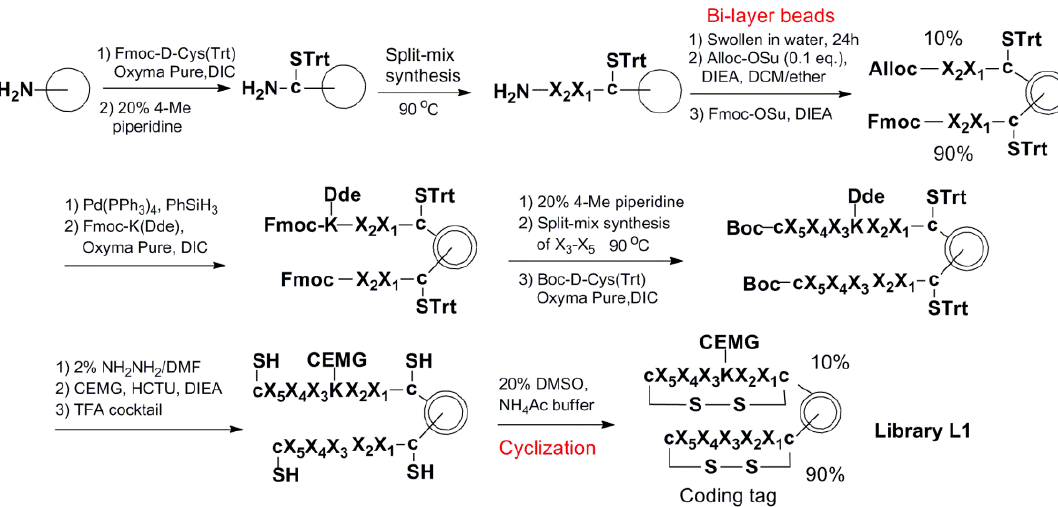
Figure 6. Synthetic scheme of OBOC library L1.